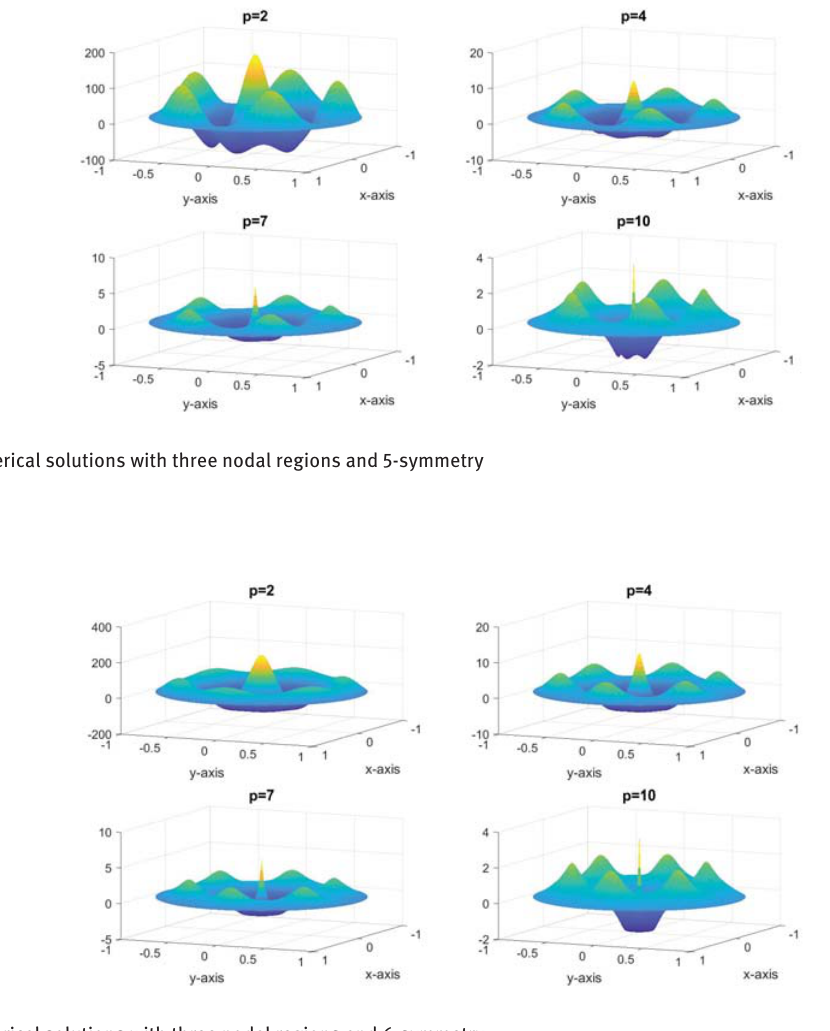
Fig. 9: Numerical solutions with three nodal regions and